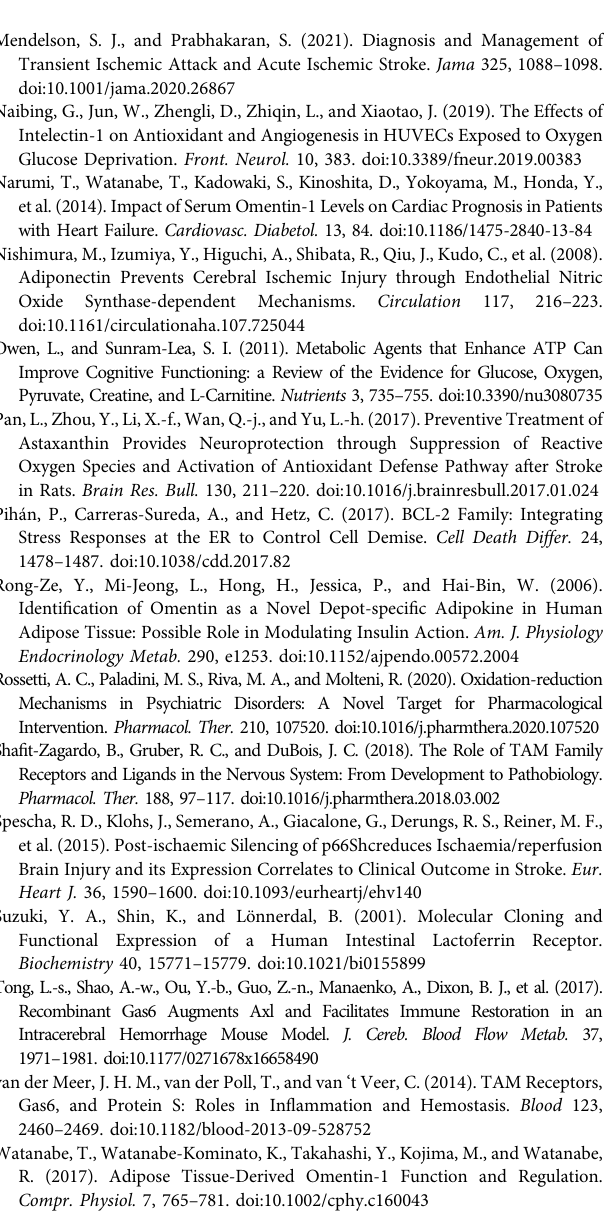
analysis of GAS6 mRNA expression normalized to the β -actin mRNA. Error bars show the standard deviation for n (cid:2) 6 measurements from representative experiments. * P < 0.05 vs. the Control group. Supplementary Figure S3 | The expression of neuronal markers in N2a cells induced by serum deprivation or H/R treatment. (A) GAP43 expression in N2a cells induced by serum deprivation or H/R treatment detected by immuno fl uorescence. (B) TUBB3 expression in N2a cells induced by serum deprivation or H/R treatment detected by immuno fl uorescence. All experiments were performed in